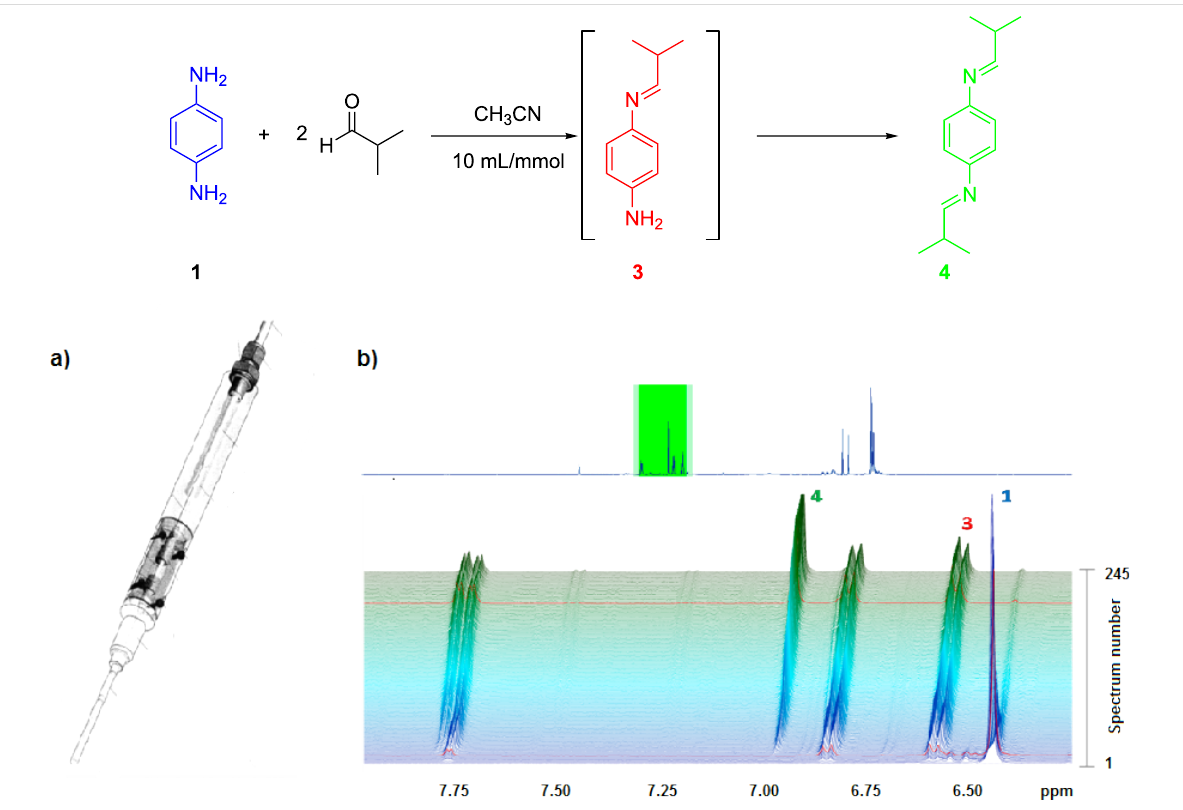
Figure 4: Reaction of p -phenylenediamine with isobutyraldehyde. (a) Flow tube and (b) 1 H NMR stacked plot (400 MHz). NMR signals used to monitor the reaction (245 spectra were recorded in 47 h). Reproduced with permission from reference [39]. Copyright 2014 The American Chemical